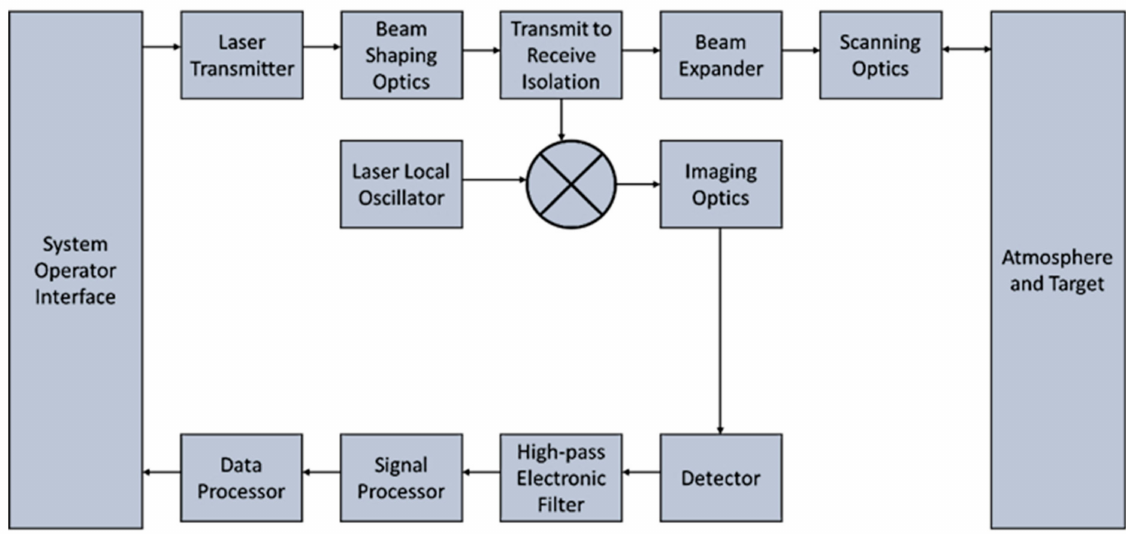
Figure 3. Coherent detection LIDAR schematic from